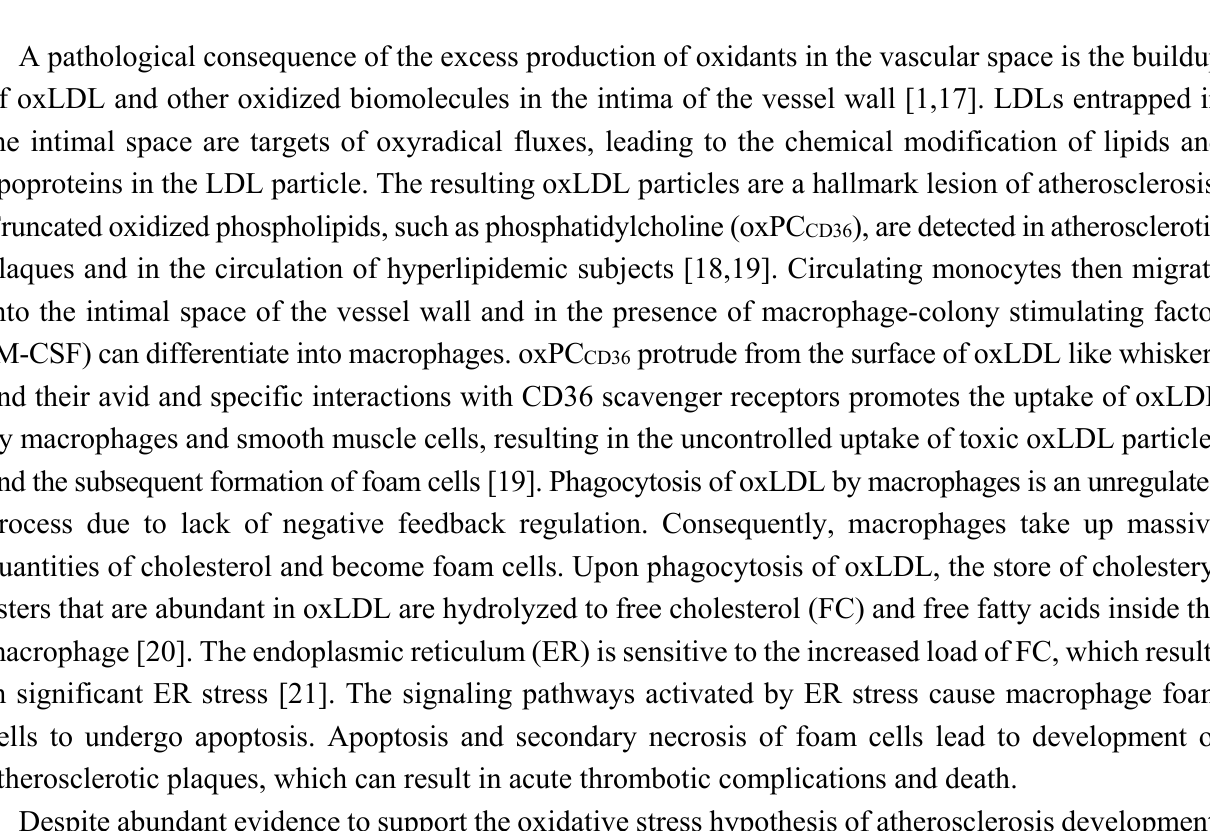
Figure 1. Oxidative stress in vascular cells. Nitric oxide (NO) and superoxide (O 2 ·− ) combine to make peroxynitrite (ONOO − ) at a diffusion-limited rate. Superoxide is rapidly metabolized by superoxide dismutase (SOD) present in mitochondria, cytoplasm, and extracellular space. Alternatively, xanthine oxidase (XO) can produce superoxide as a byproduct of its activity. In a diseased vessel, these molecules can become toxic to the cell. Because of its negative charge O 2 ·− crosses lipid membranes via ion channels, whereas H 2 O 2 can passively diffuse through the lipid bilayer. Activation of the CB 1 receptor can enhance ROS and pro-inflammatory cytokine production. On the other hand, activation of the CB 2 receptor is a protective mechanism due to the increased production of anti-inflammatory